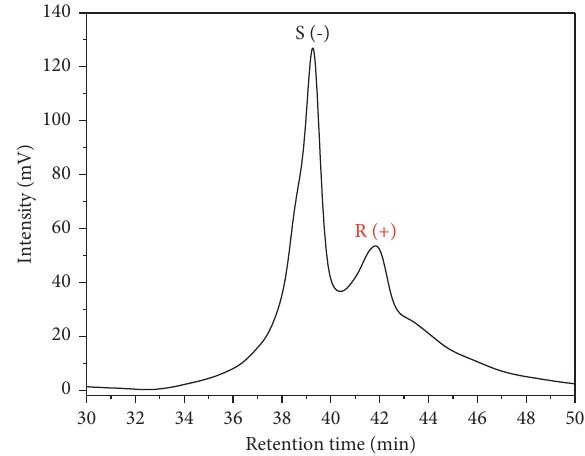
Figure 10: Chromatogram of rac -citronellal separation using MMIP B column. Mobile phase (A) H 2 O and mobile phase (B) acetonitrile 90% in (A), gradient elution: 30–60% B for 12mins, 60–70% B for 18mins, 70–20% for 30mins, detection wavelength at 253nm; flow rate